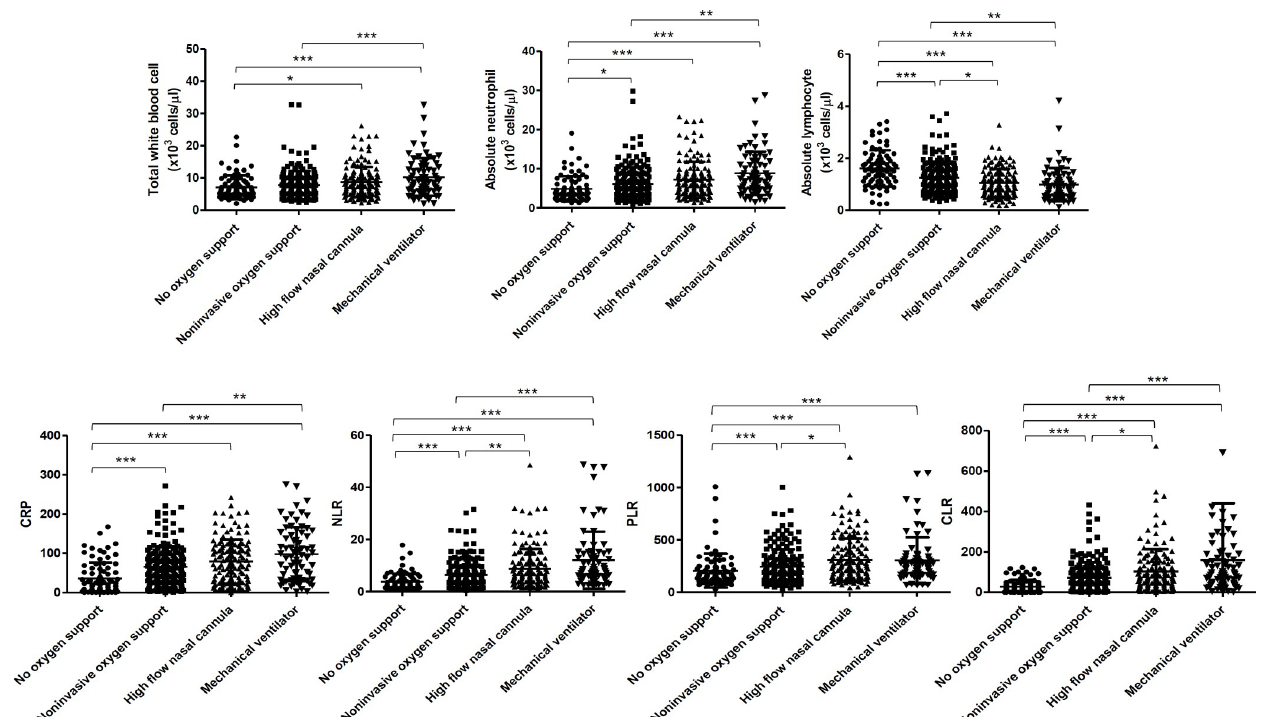
Fig 2. Association between potential parameters and types of oxygen support among COVID-19 patients. The illustration of total white blood cell count, absolute neutrophil count, absolute lymphocyte count, C-reactive protein (CRP), neutrophil/lymphocyte ratio (NLR), platelet/lymphocyte ratio (PLR) and C-reactive protein/lymphocyte ratio (CLR) in association with types of oxygen support. The requirement of oxygen support in this study was divided into four groups: no oxygen support, noninvasive oxygen support (oxygen mask bag and low flow oxygen cannula), high-flow nasal cannula and mechanical ventilator, respectively. Error bars denoted mean ± SD. The significance was determined by one-way ANOVA and Dunn’s Multiple Comparison Test � P � 0.05, �� P � 0.01 and ��� P � 0.001, respectively.